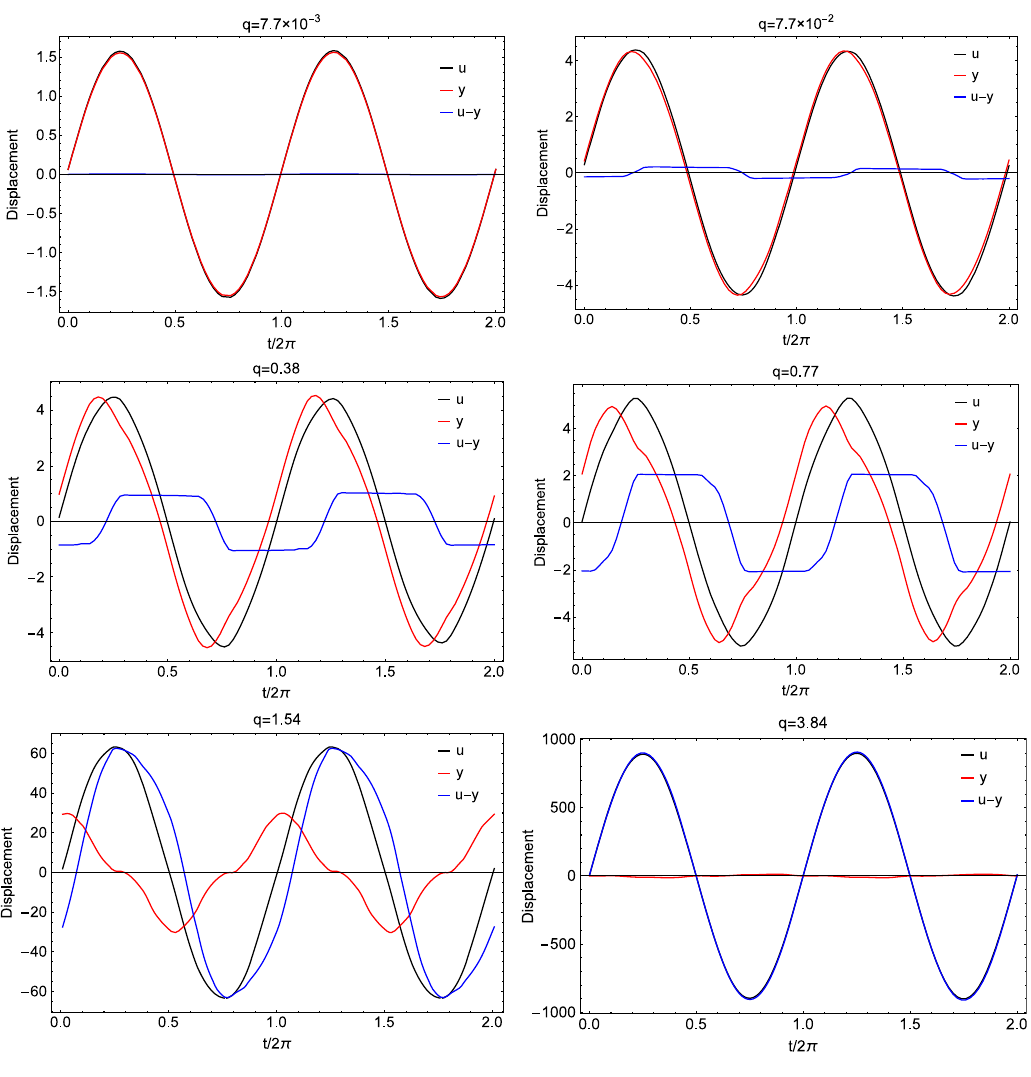
FIG. 7. Normalized displacements ( u; y; u − y ) over time with an increasing drive ( q ).